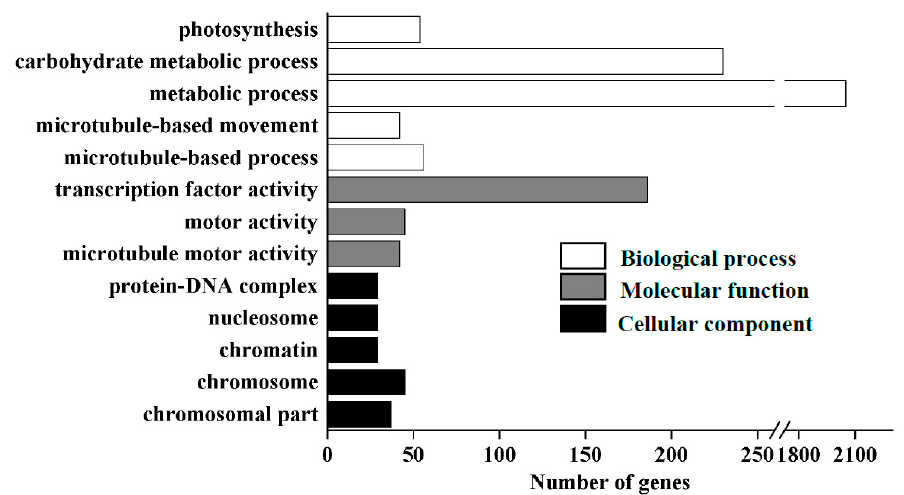
Figure 3. The significantly enriched GO terms for differentially expressed genes in “Nanlin895” roots exposed to boron deficiency. The x-axis and y-axis indicate the names of clusters and gene number assigned to the cluster, respectively.